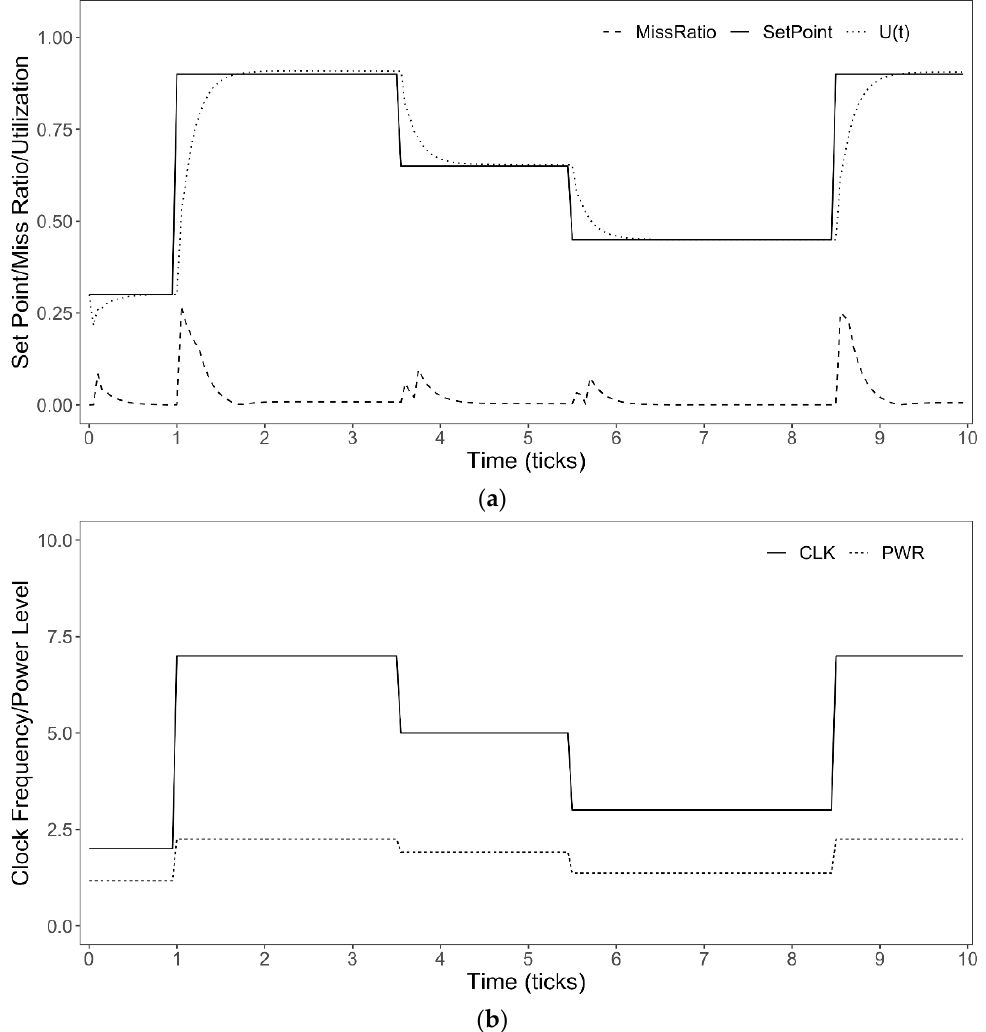
Figure 6. ( a ): Utilization Load/Deadline Miss Ratio via Step-Load, ( b ): Power/Frequency Levels via Step-Load.